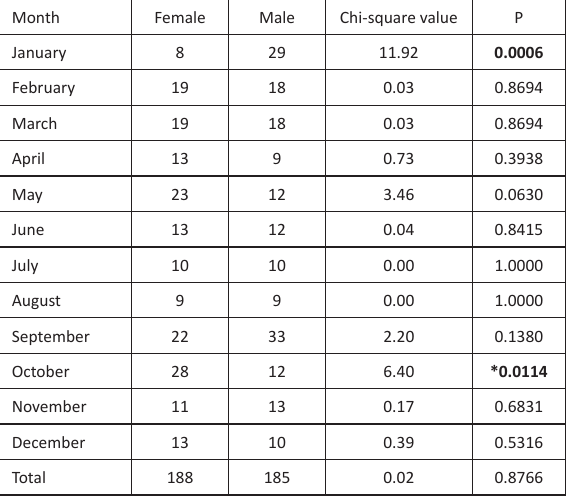
Table 1. Monthly gender wise frequency of individuals and the chi-square test for expected 1:1 sex ratio. (P values in bold are